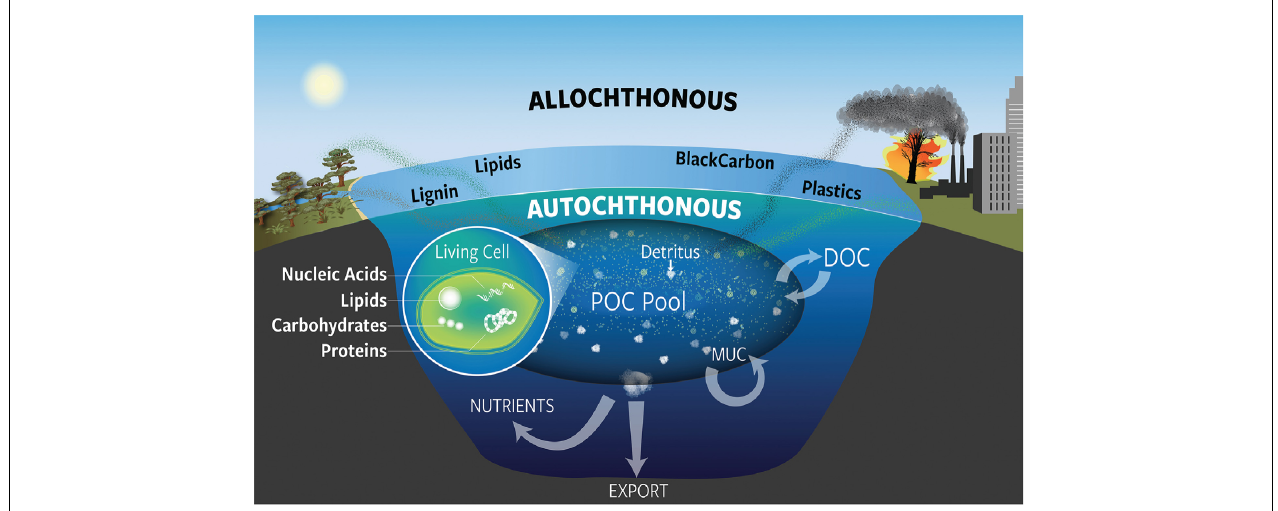
FIGURE 1 | Conceptual overview of marine particulate organic carbon (POC) in the ocean. POC includes components of living cells as well as dead material (detritus), and originates from both allochthonous and autochthonous sources. The POC pool can also exchange material with the dissolved OC (DOC) pool through aggregation and disaggregation of particles. This process and others may be involved in the formation of the molecularly uncharacterized component (MUC), which may incorporate both autochthonous and allochthonous OC.